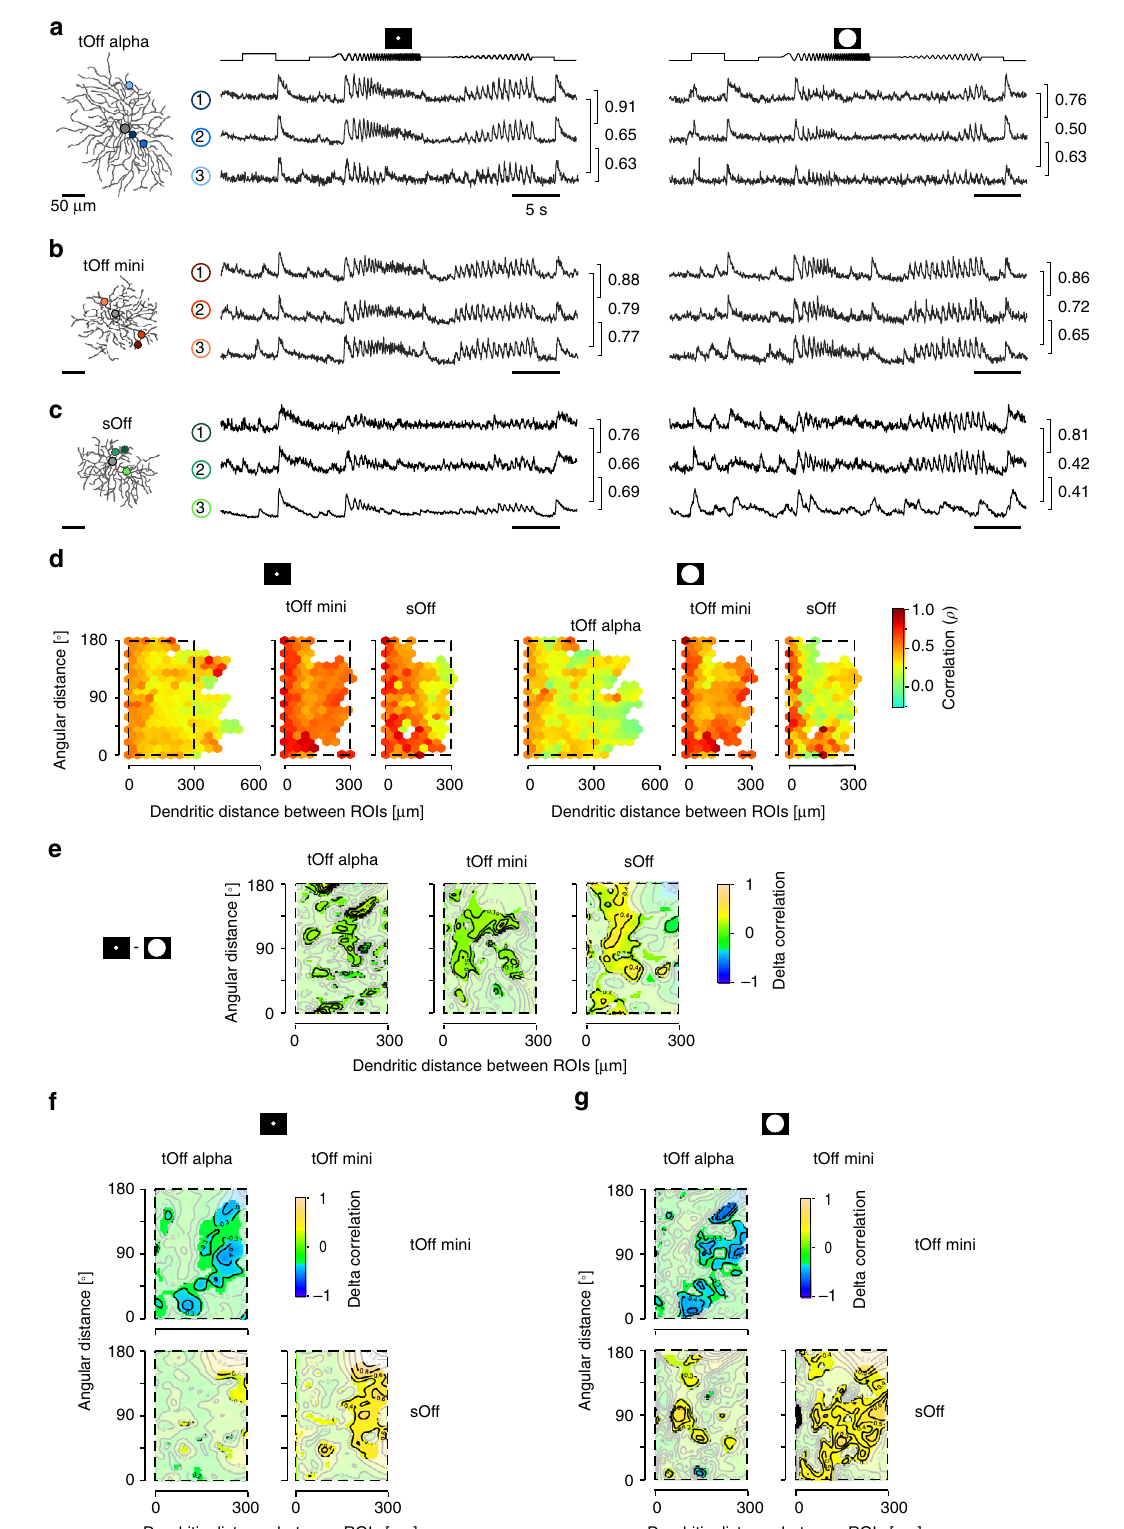
Taken together, our data suggest that spatio-temporal integra- tion is tuned across the RGC dendritic arbour in a highly type- speci fi c manner (Fig. 5f, g). The studied RGC types ranged between two main dendritic integration pro fi les: The fi rst pro fi le featured strongly isolated dendrites (e.g. in tOff alpha) and may